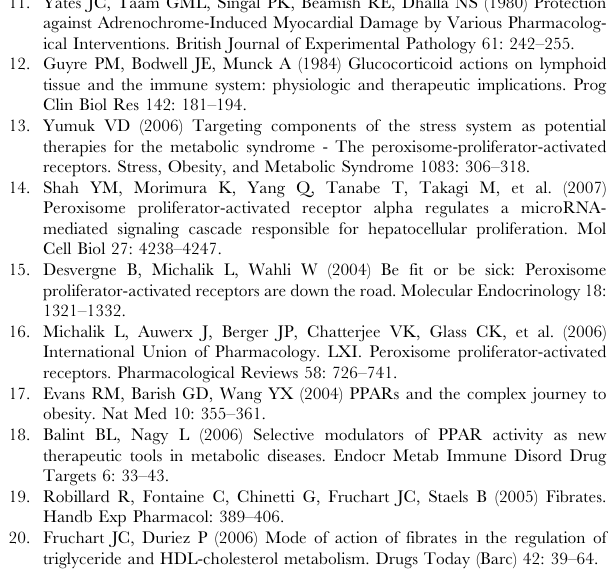
Figure S2 Correlation between stress- and AR-induced alterations in PPAR a and HNF4 a expression. A. Correla- tion between stress-induced alterations in PPAR a and HNF4 a relative mRNA expression. B. Correlation between a 1 -AR- induced alterations in PPAR a and HNF4 a relative mRNA expression. C. Correlation between b -AR induced alterations in PPAR a and HNF4 a relative mRNA expression. D. Correlation of a a and HNF4 a mRNA relative 2 -AR induced alterations in PPAR